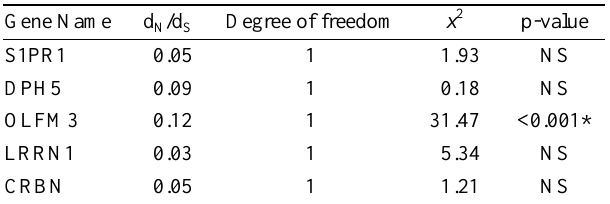
Table 3. Likelihood estimates of different evolutionary